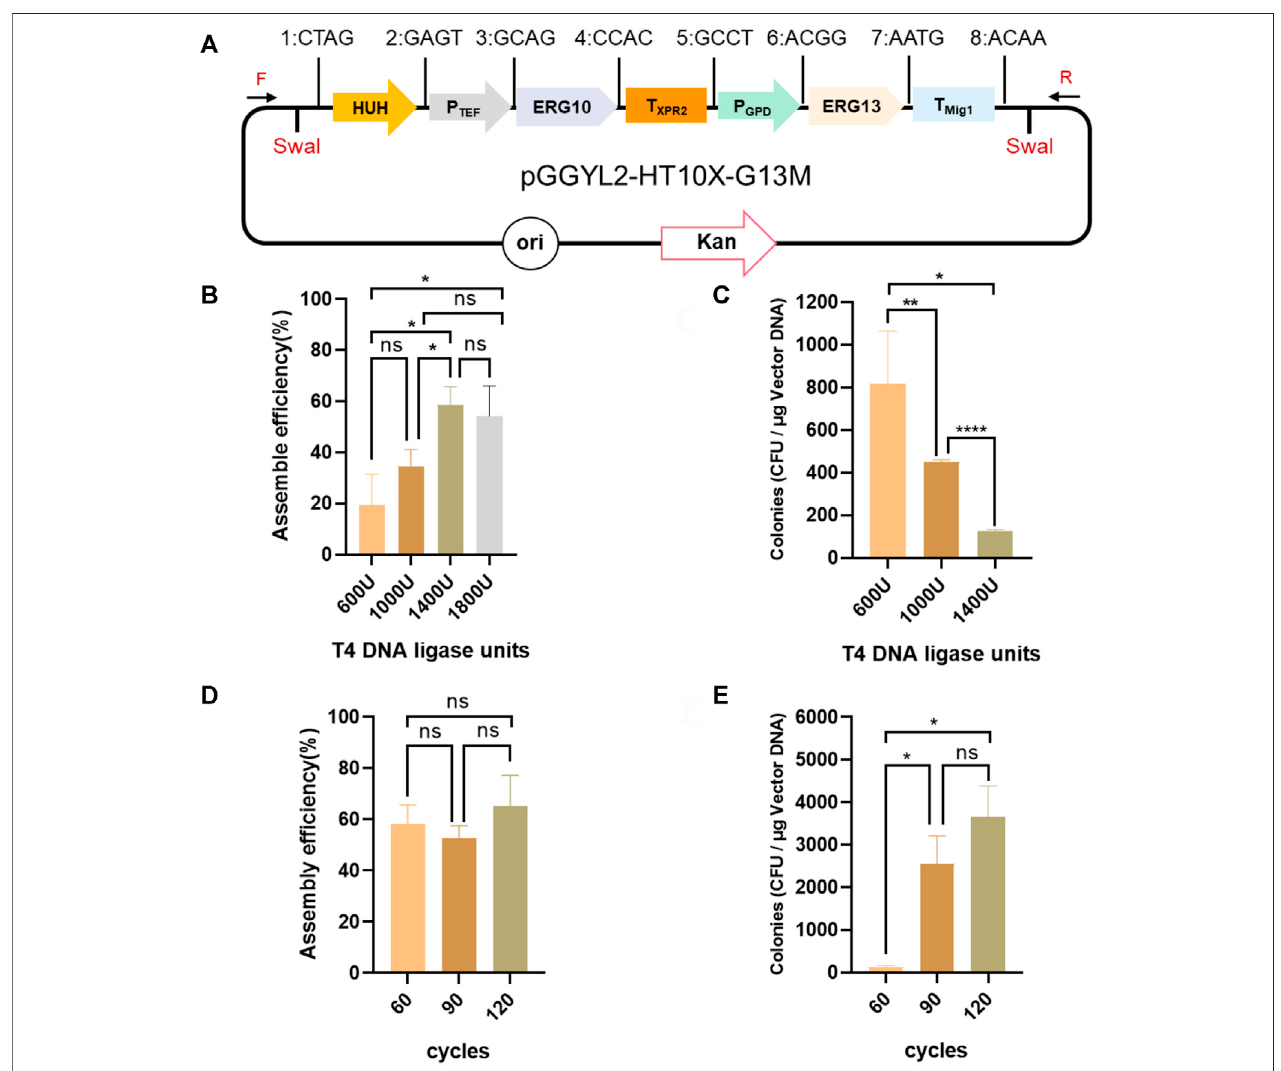
FIGURE3| Assembly ofseven fragments using YALIcloneNHEJ. (A) Schematic representation ofthecompletelyassembled plasmid pGGYL2-HT10X-G13M. (B) The effect ofdifferent amounts ofTakara T4 DNA ligase on the assembly ef fi ciency ofseven DNA fragments. (C) The effect of different amounts of Takara T4 DNA ligase on the number of transformants. (D) Assembly ef fi ciency using different numbers of reaction cycles with 1,400 U of T4 DNA ligase. (E) Number of transformants using different numbers of reaction cycles with 1,400 U of T4 DNA ligase. The primer F/R was used to amplify the assembled fragments.